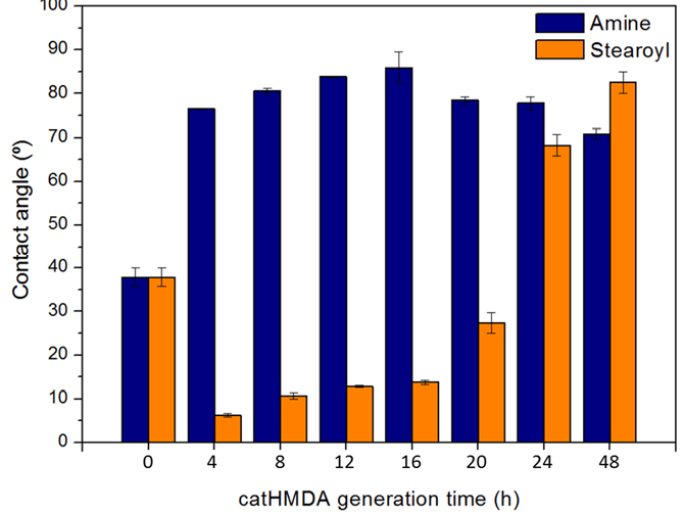
Figure 6. Contact angles of catHMDA generated at different times (4–48 h), after incubation with 1-hexadecanamine (blue) and stearoyl chloride (orange). Both incubations are carried out for 24 h in hexane. Data is shown as mean ± standard deviation.